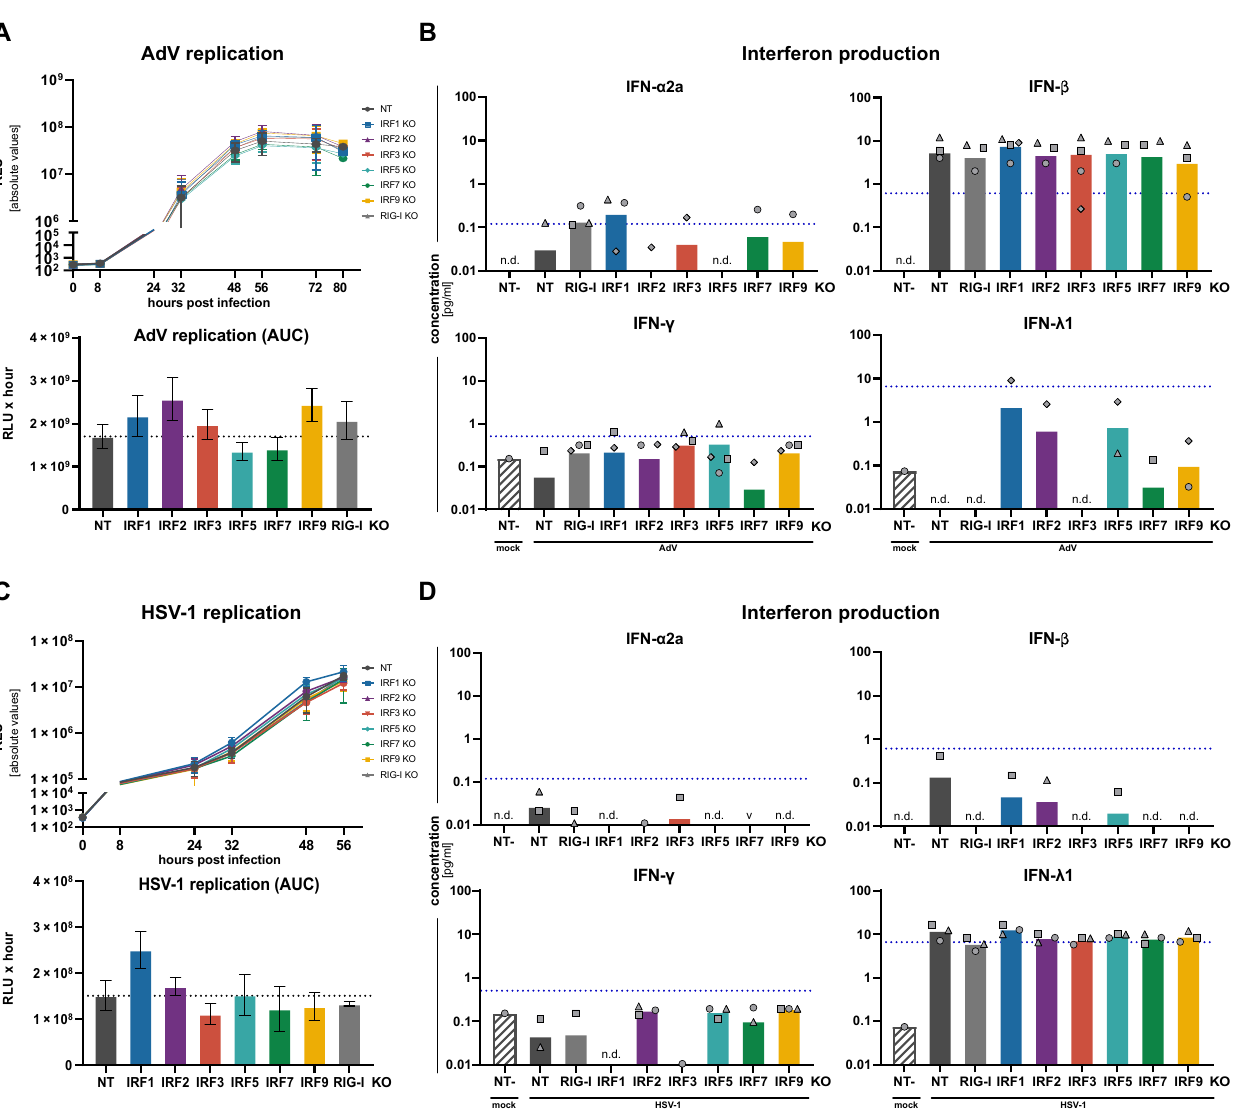
Figure 6. Impact of IRF KO on DNA virus replication and IFN production. A549 NT , A549 IRF (as indicated) KO , and A549 RIG-I KO cells were infected with Adenovirus (AdV, Ad5 ∆ fiberIL) at an MOI of 0.05 ( A , B ), or with Herpes simplex virus 1 (HSV- 1, HSV1(17 + )Lox-CheP2AGLuc) at an MOI of 0.1 ( C , D ). ( A , C ) Viral replication was assessed by measuring luciferase reporter activity at the indicated time points (top panels); the area under the curve (AUC) of the time courses is shown in the lower panels. Viral replication time-courses and AUC plots show mean ± SD of three independent experiments. ( B , D ) Supernatants of the infected cells were sampled at 56 h.p.i. (AdV, B ) or 48 h.p.i. (HSV-1, D ) and analyzed for their IFN contents by an electroluminescent multiplex assay. Bars show means of three independent experiments with the three individual data points shown as symbols (same shapes indicate same experiment). “n.d.” indicates all measurements were non-detectable, “ ∨ ” indicates all measurements being below the cut-off of the Y-axis, and missing symbols indicate individual measurements below the cut-off or non-detectable. Dashed blue lines indicate the lower limit of quantification (LLoQ) for the respective